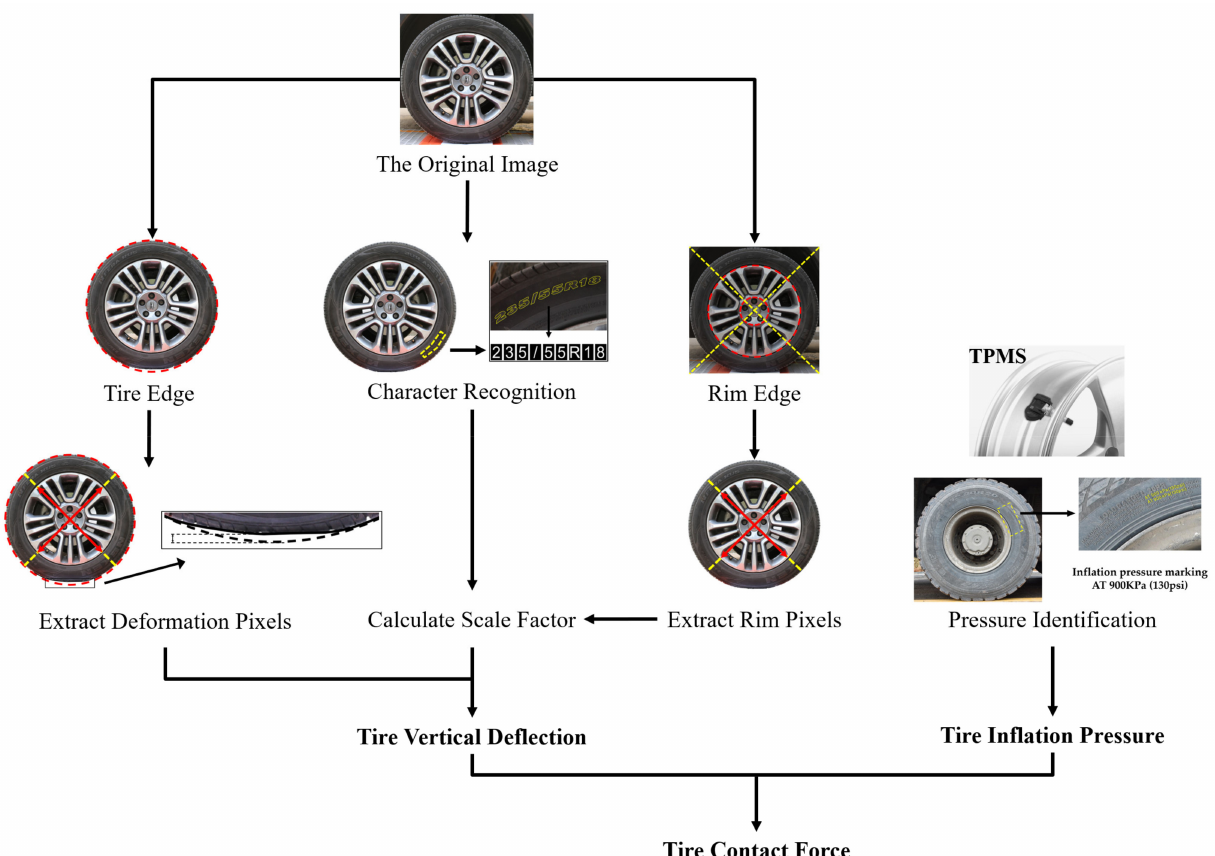
Figure 15. Flowcharts: vision-based tire force identification